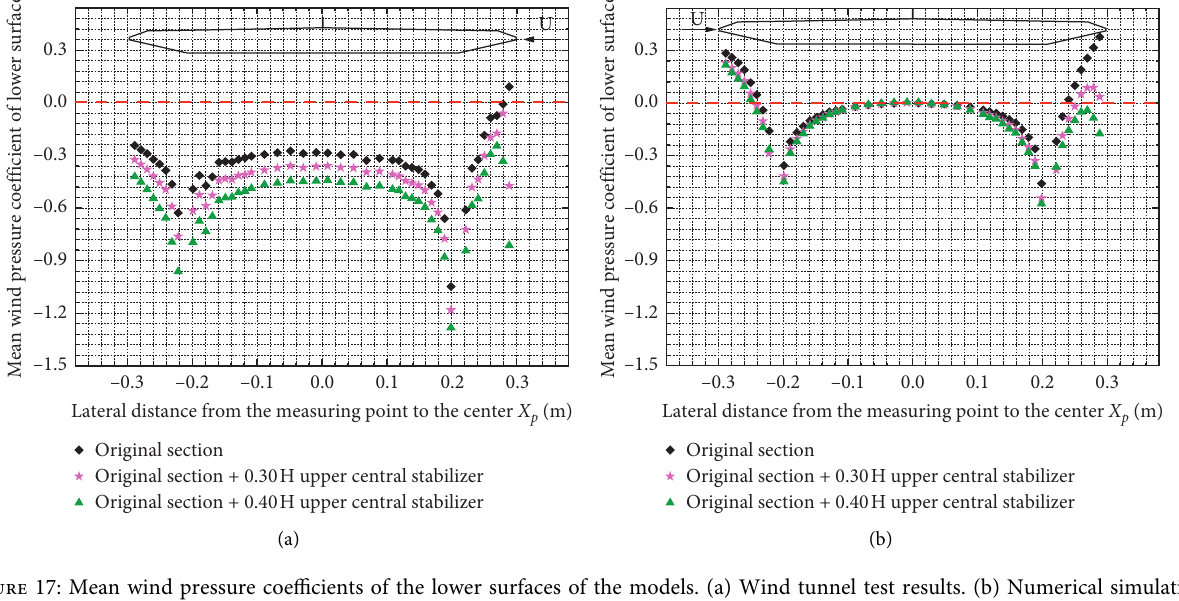
Figure 17: Mean wind pressure coefficients of the lower surfaces of the models. (a) Wind tunnel test results. (b) Numerical simulation